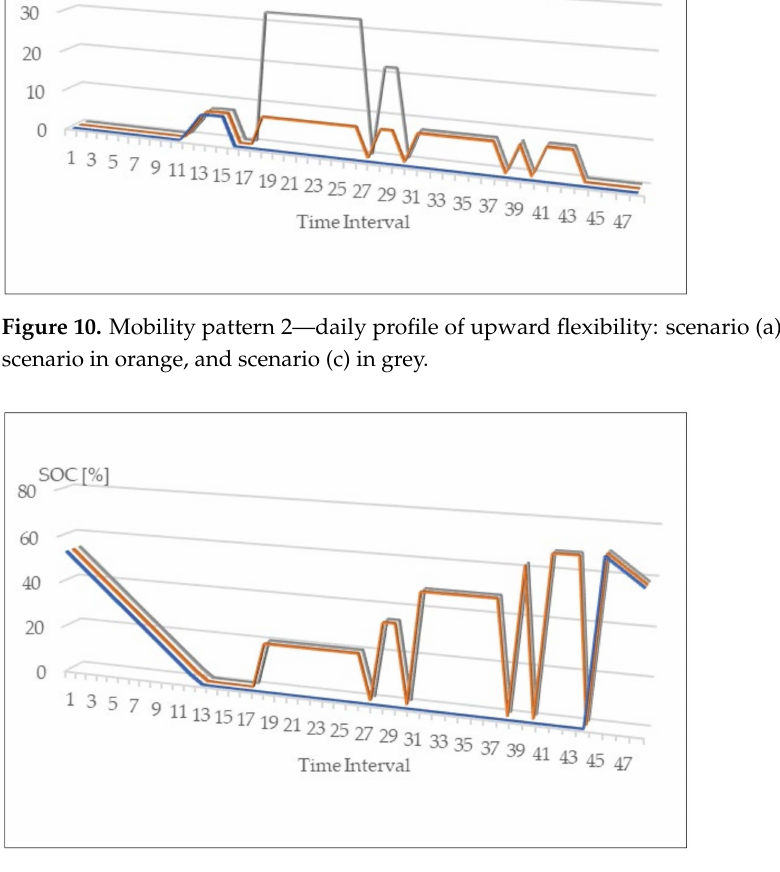
Figure 11. Mobility pattern 2—daily profile of downward flexibility: scenario (a) in blue, scenario (b) scenario in orange, and scenario (c) in